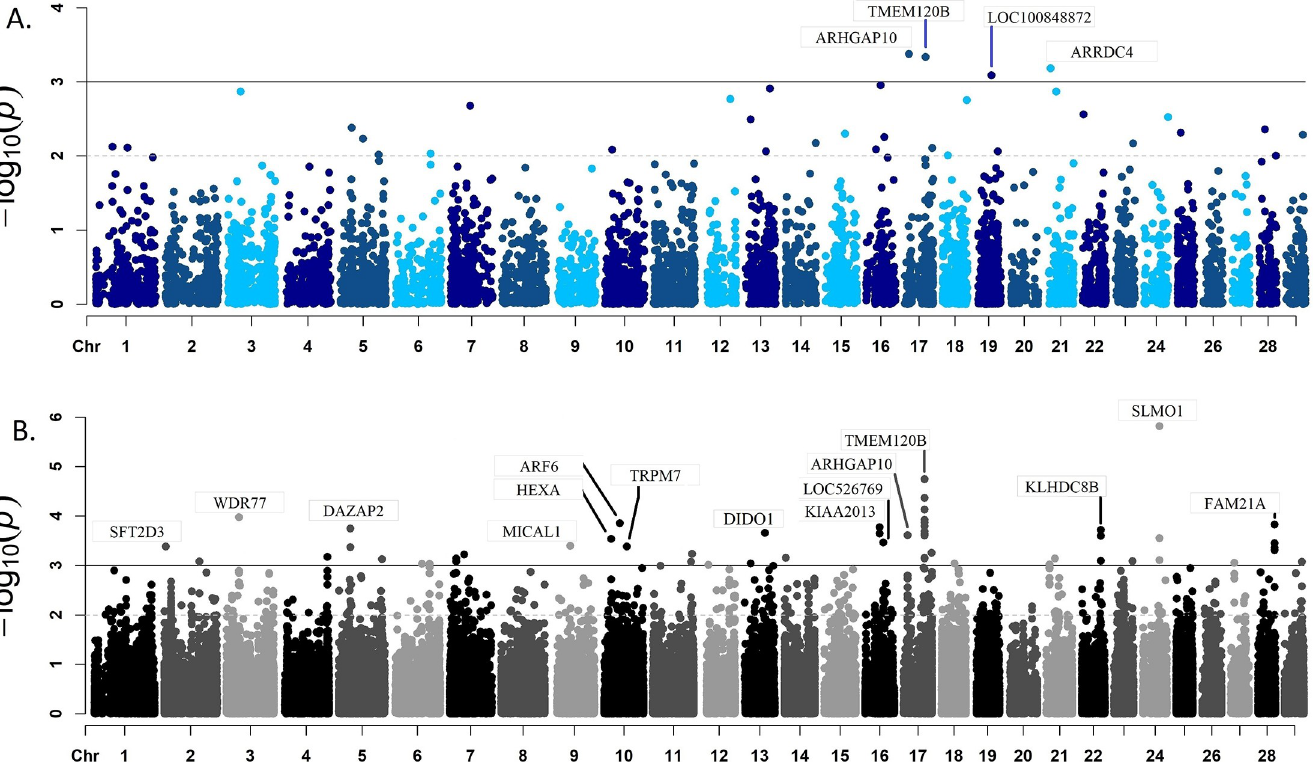
Fig 1. Results from the association analysis between gene expression (A) or exon expression (B) and meat quality index. The x-axis represents the location of the gene or exon across the bovine genome. The black line shows a p-value threshold of 1x10 -3 .